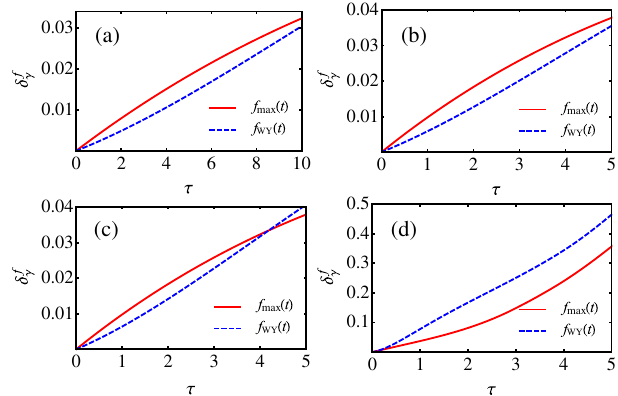
FIG. 5. Plot of the relative difference δ f γ , Eq. (19), indicating the tightness of the QSLs (the smaller δ f γ , the tighter the bounds) corresponding, respectively, to the quantum Fisher information (red solid line) and the Wigner-Yanase skew information (blue dashed line), for a qubit initially in the plus state and undergoing a transversal dephasing process with (a) Γ ¼ 0 . 1 and ω 0 ¼ 0 . 01